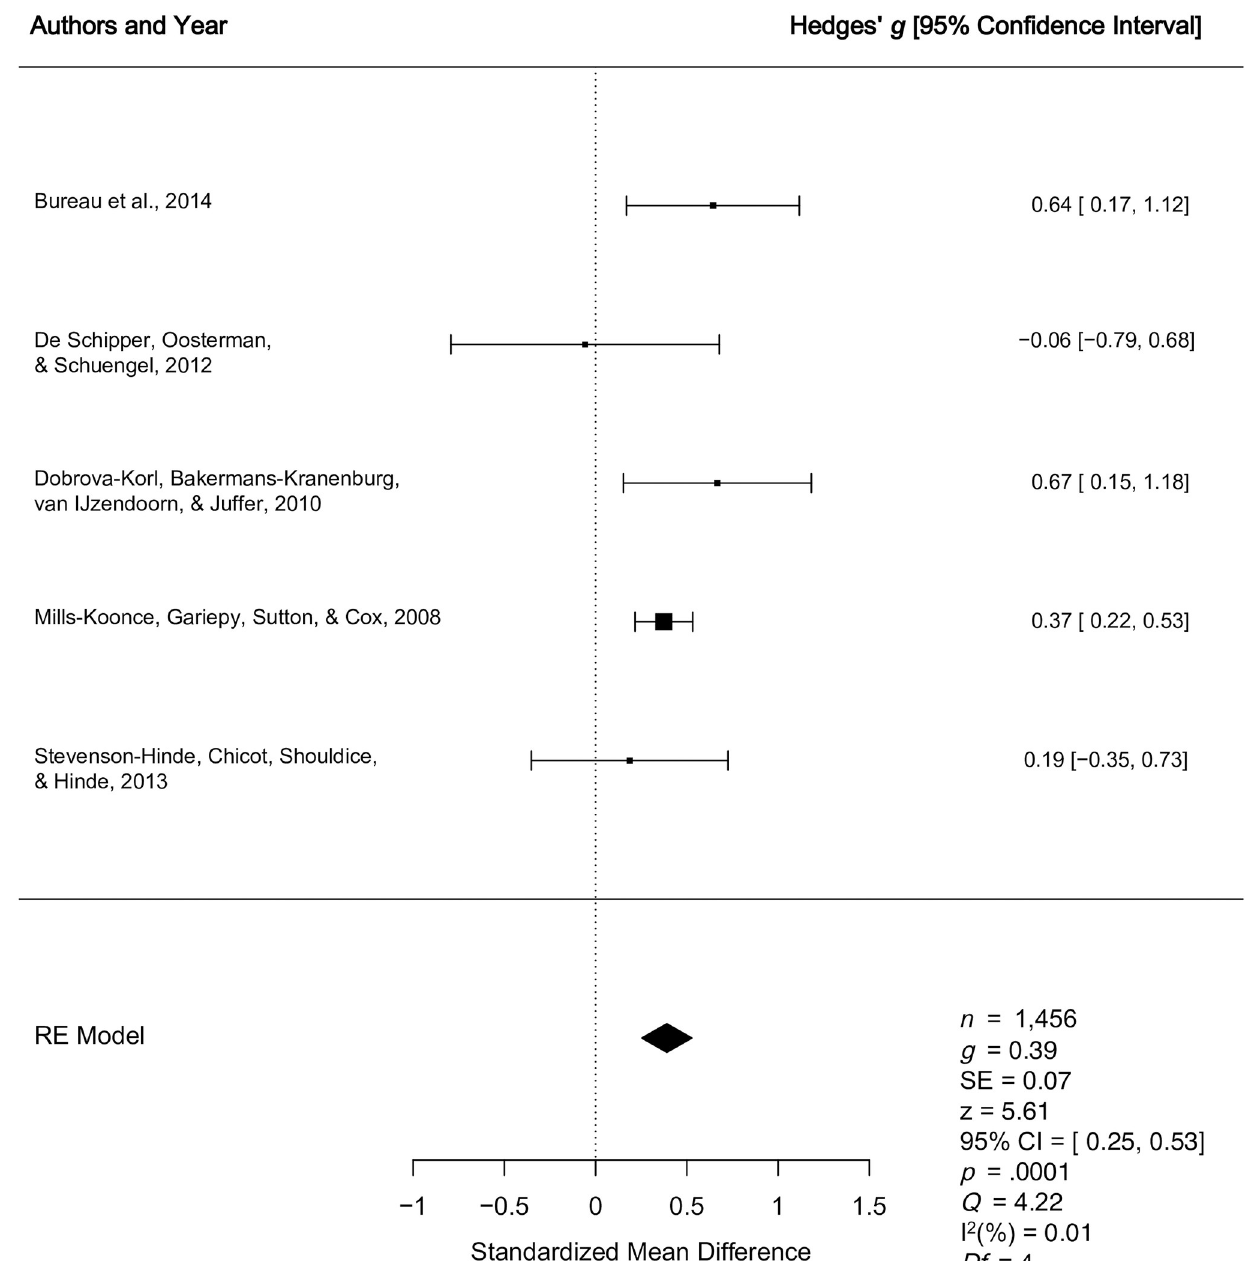
Fig 10. Forest plot for the concurrent relationship between multidimensional caregiver sensitivity and organized versus disorganized preschool attachment. RE = Random Effects Model; g = Hedges’ g; Q = Cochran’s heterogeneity statistic; Q; I 2 = percentage of variability across studies that is due to between-study